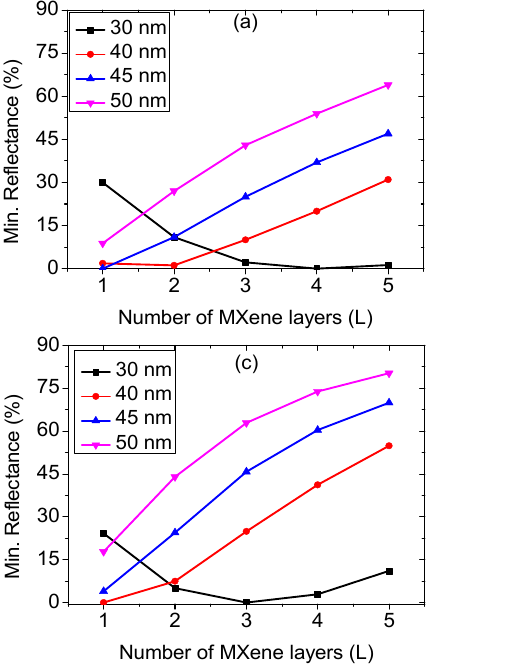
Figure 4 depicts the refractometric sensor sensitivity as a function of the number of Ti 3 C 2 T x sheets for various metal layer thicknesses. The number of Ti 3 C 2 T x sheets varies be-